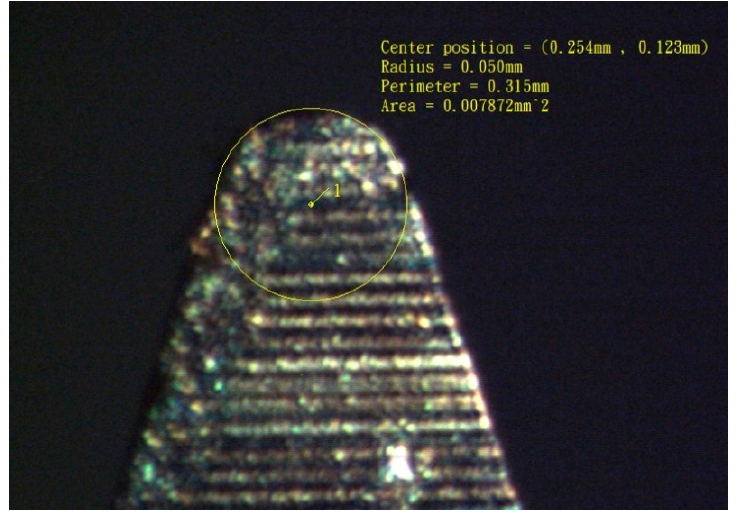
Figure 2. Nose radius of the microshaper measured on a microscope. The knife radius has radius of 50 μ m.